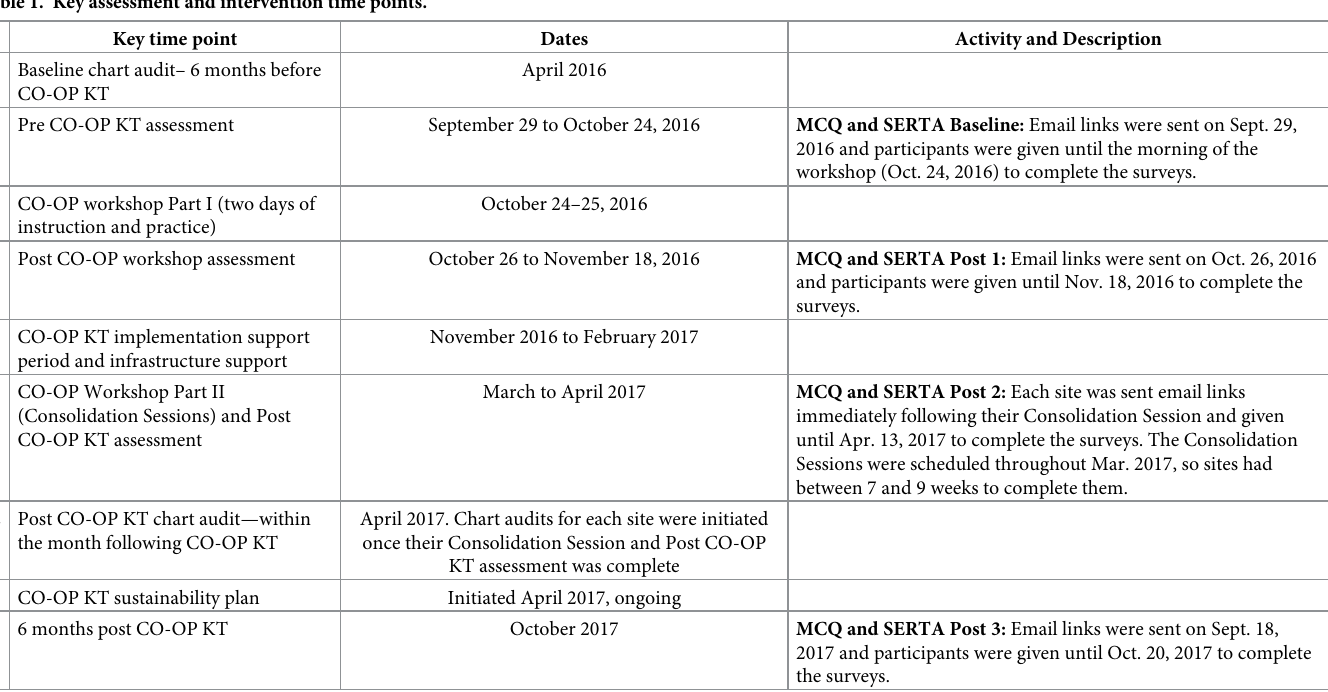
Table 1. Key assessment and intervention time